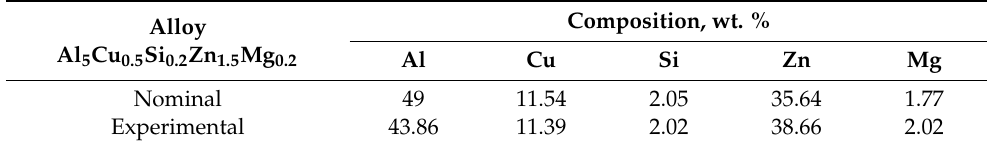
Table 1. Complex concentrated alloy